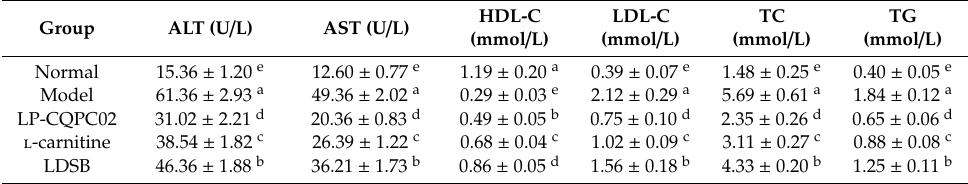
Table 5. Levels of aminotransferase (AST), aminotransferase (AST), high density lipoprotein cholesterol (HDL-C), low density lipoprotein cholesterol (LDL-C), total cholesterol (TC) and triglyceride (TG) in serum of mouse ( n = 10).